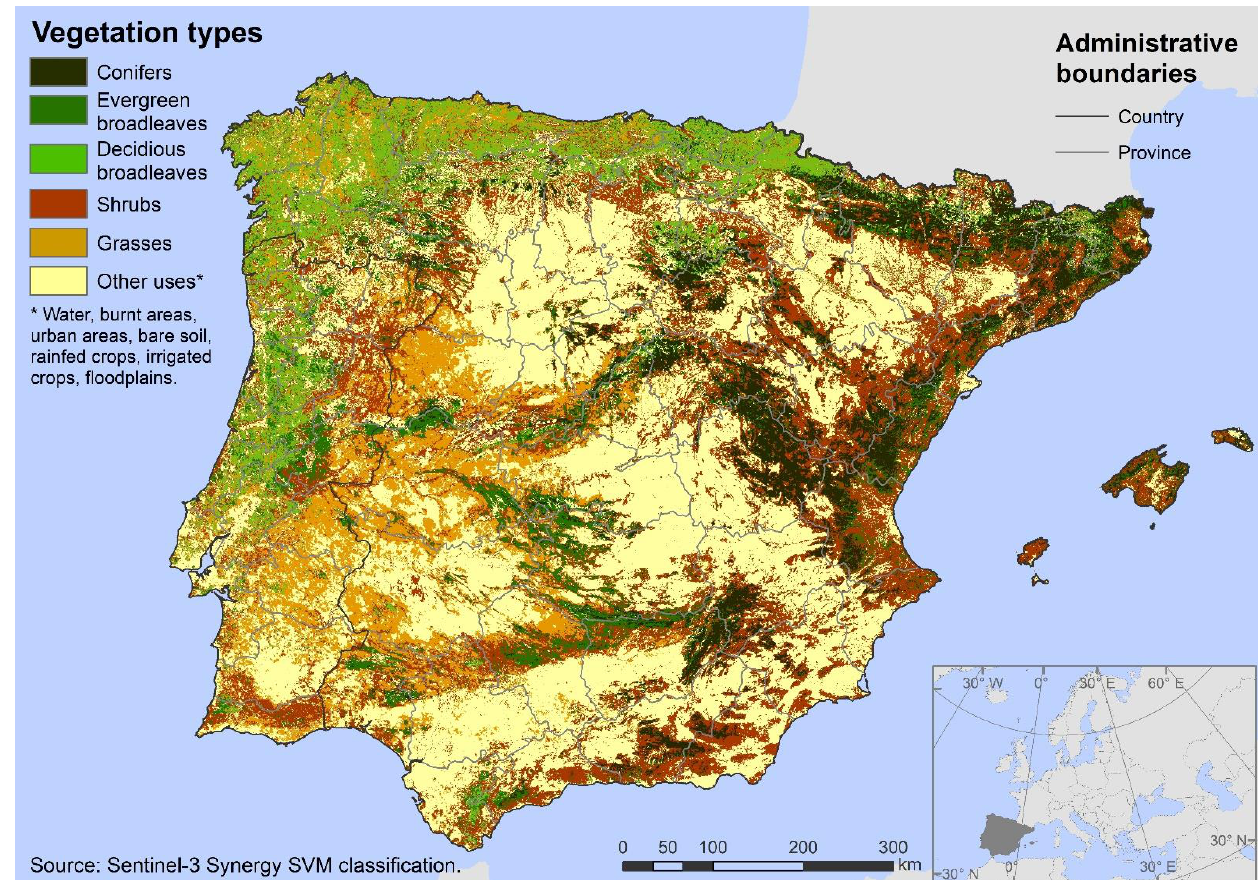
Figure 5 . Vegetation map for the Iberian Peninsula and the Balearic Islands (2020 – 2021). Figure 5. Vegetation map for the Iberian Peninsula and the Balearic Islands